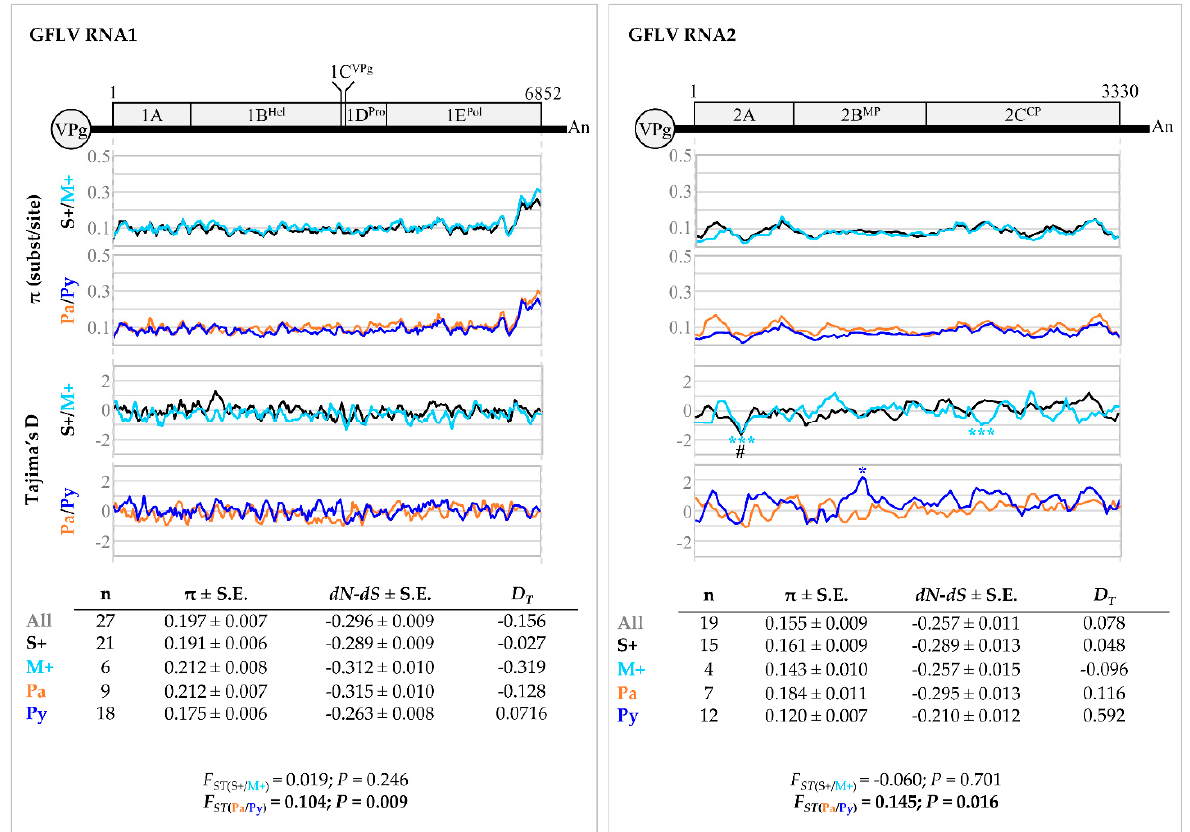
Figure 6. Genetic diversity analyses of grapevine fanleaf virus (GFLV) ORF1 and 2 sequences. Graphics represent genetic diversity ( π , substitution per site) along each ORF1 and ORF2 sequence and Tajima’s D ( D T ) for evolution study (# p < 0.10, * p < 0.05, *** p < 0.001). Sequences were grouped according to either the phenotypic category or the vineyard site. A colour code was applied for each population: black for ‘S+’, cyan for ‘M+’, orange for ‘Pa’, deep blue for ‘Py’ and dark grey for all sequences. Number of sequences (n), overall genetic diversity π (± standard error, S.E.); the diversity of synonymous ( dS ) and nonsynonymous ( dN ) substitutions ( dN − dS < 0: negative/purifying selection; dN − dS = 0: neutral/conservative selection; dN − dS > 0: positive/diversifying selection) and the overall Tajima’s D ( D T ) (for all D T values p > 0.10, non-significative) are given in the tables below the graphs. D T = 0 corresponds to a mutation-drift equilibrium, D T > 0 indicates balancing selection, sudden population contraction and D T < 0 distinguishes a recent selective sweep, population expansion after a recent bottleneck. Genetic differentiation of GFLV populations is expressed as the fixation index ( F ST ) with associated p -value ( p ). Significance ( p ≤ 0.05) is indicated in bold.